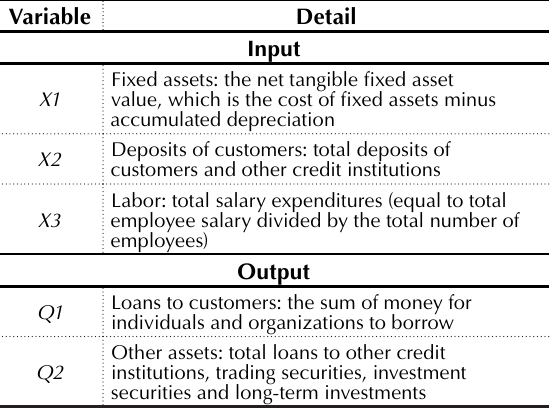
Table 2. Input and output variables in the